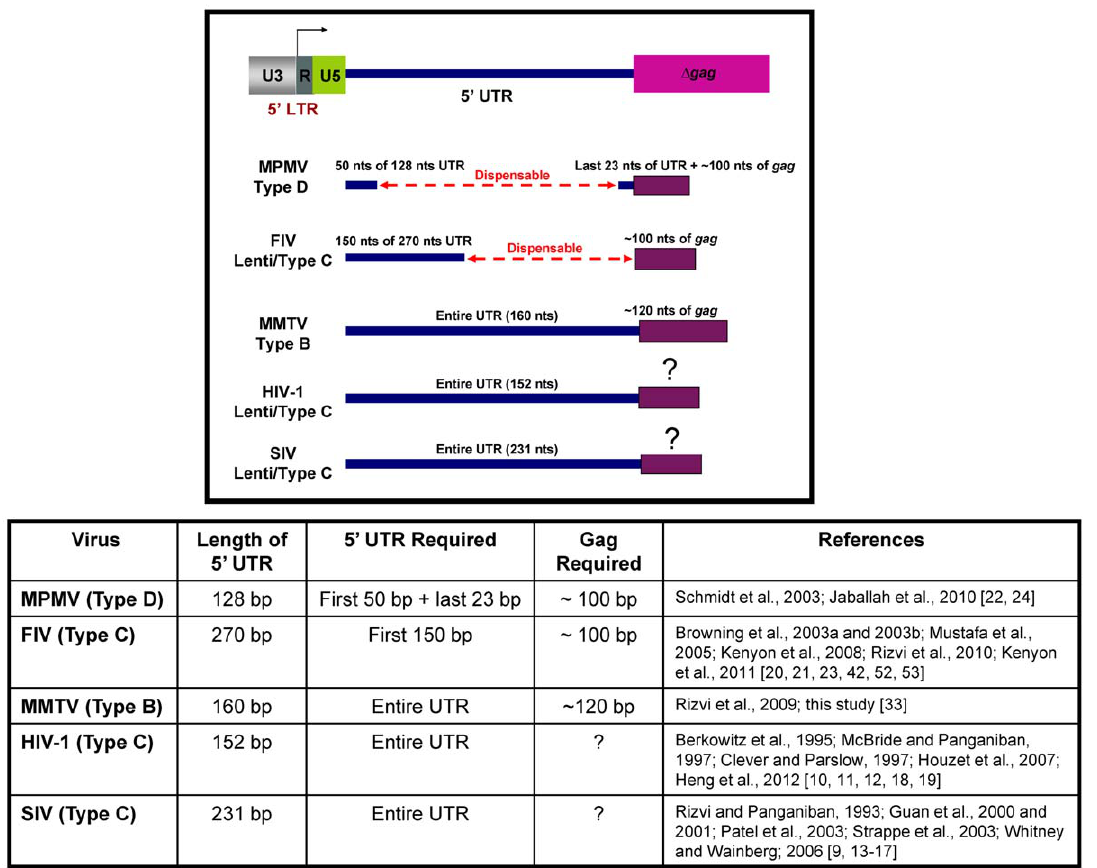
Figure 6. Schematic representation of the packaging determinants observed empirically in different retroviral systems starting from nt + 1 in R to the beginning of gag . The figure compares the published data pertaining to the requirements of the 5 9 UTR and gag sequences for optimal RNA packaging in different retroviruses. The table provides further details of the RNA packaging determinants required as observed in various studies referenced in the last column.